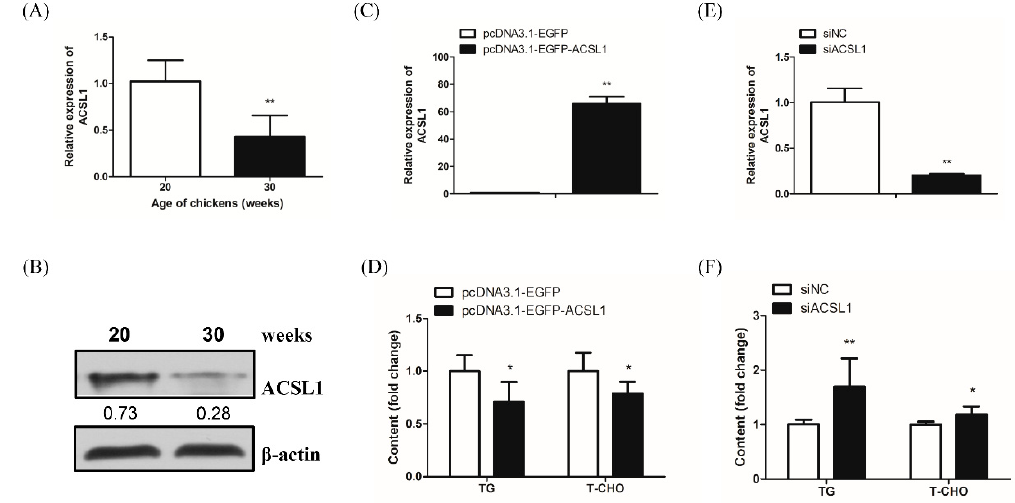
Figure 4. ACSL1 represses hepatocyte TG and T-CHO levels. ( A ) qRT-PCR analysis of ACSL1 mRNA expression in the livers of pre-laying (20 weeks old) and peak-laying (30 weeks old) hens; ( B ) Western blotting analysis of ACSL1 protein expression in the livers of pre-laying (20 weeks old) and peak-laying (30 weeks old) hens. The digit means the gray value ratio of the target band and the internal reference band; ( C ) detection of the ACSL1 overexpression by qRT-PCR at 24 h after the transfection of pcDNA3.1-ACSL1-EGFP; ( D ) ELISA analysis of intracellular TG and T-CHO levels in LMH cells after ACSL1 gene overexpression for 24 h; ( E ) detection of ACSL1 gene knockdown by qRT-PCR at 24 h after transfection with siACSL1; ( F ) ELISA analysis of intracellular TG and T-CHO levels in LMH cells after ACSL1 gene knockdown for 24 h. Data are presented as mean ± SD ( n = 4 to 6). * p < 0.05, ** p < 0.01.